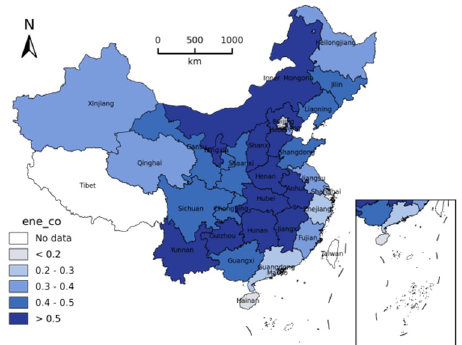
Figure 2. Distribution of energy consumption structure (2008–2019).